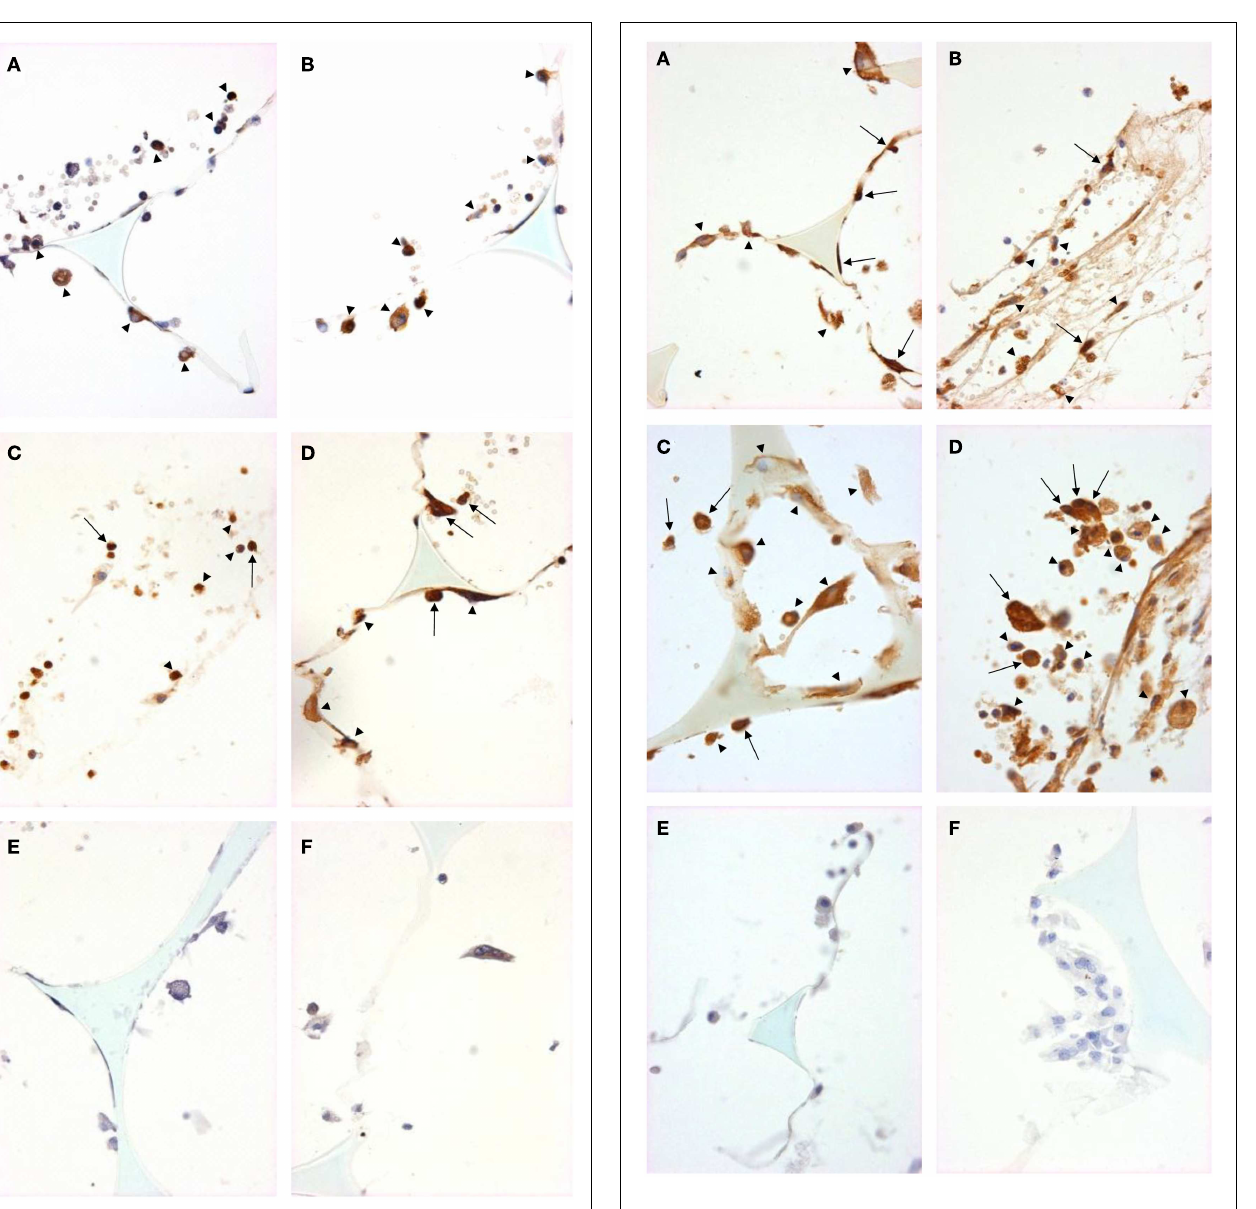
Immunohistochemistry for α -smooth-muscle-cell-actin ( α - SM-actin) was used to quantify the presence of vascular SMC and staining for GSL to quantify macrophages. As